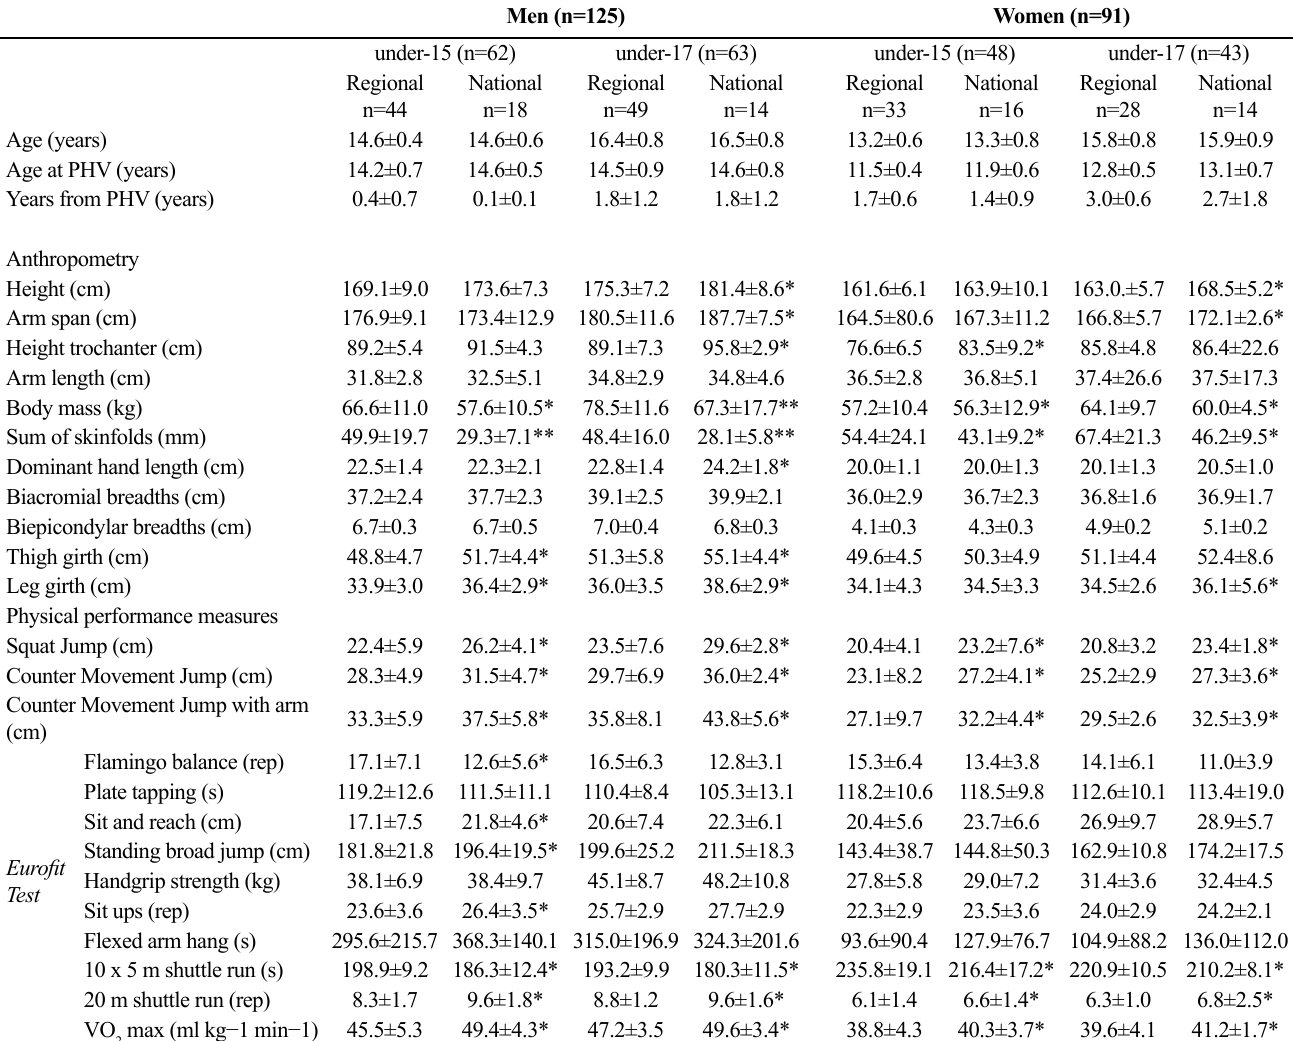
Table 2. Mean and standard deviation of the anthropometric and conditional characteristics of male and female handball players by category and performance